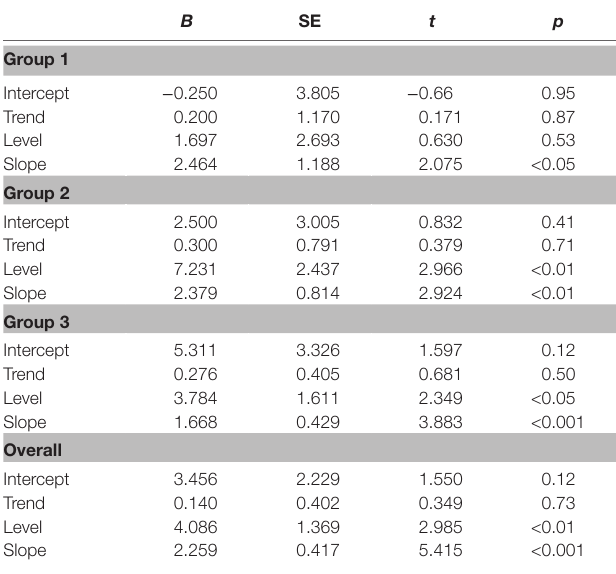
TABLE 4 | Regression model for expressive vocabulary across all participants (level